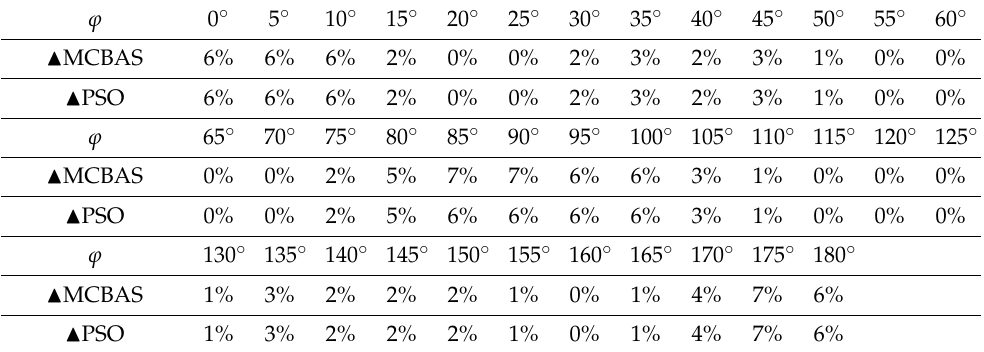
Table 6. The total power conversion improvement rate compared to the baseline in 2 × 2 matrix WF.